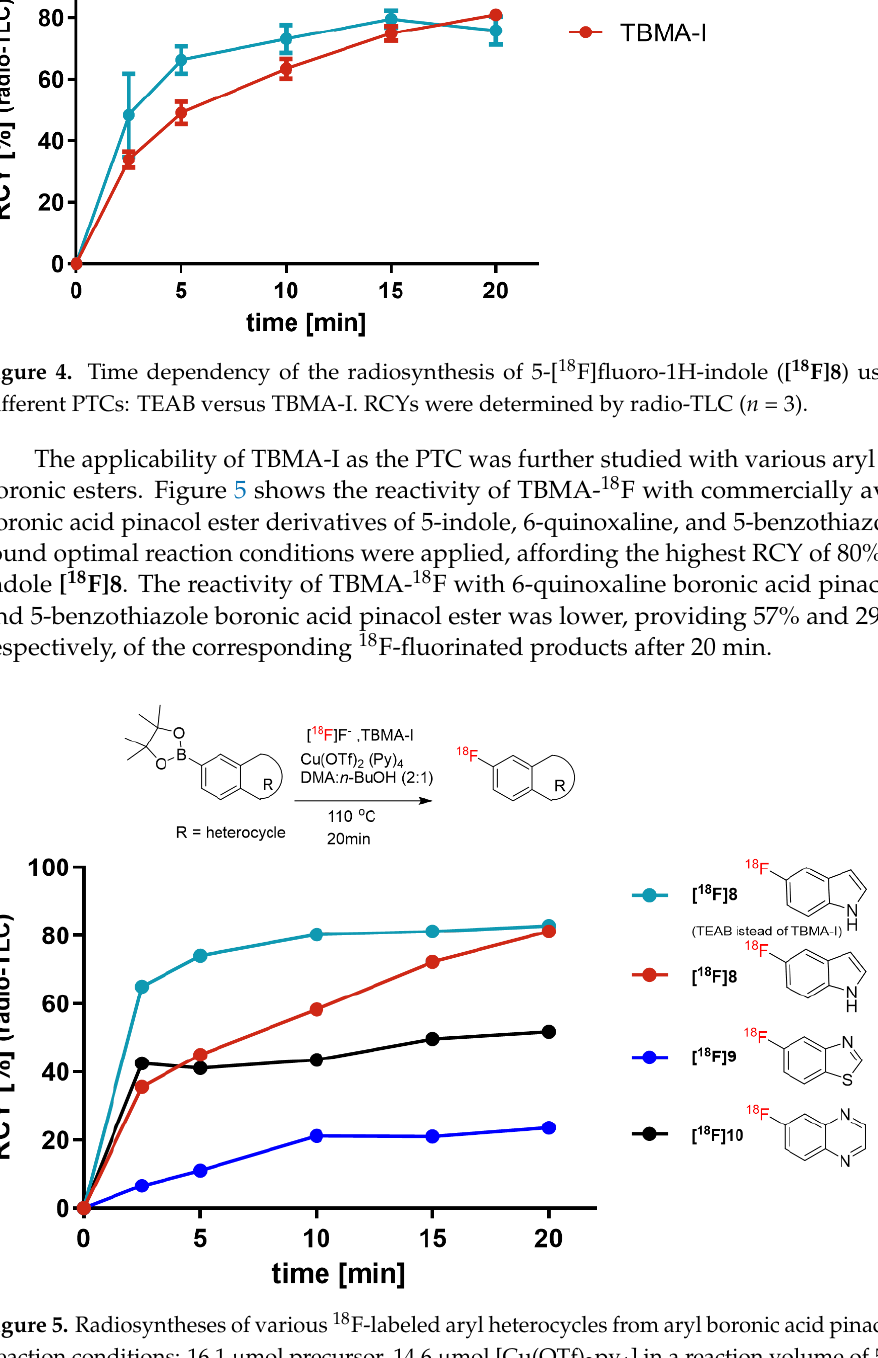
Figure 5. Radiosyntheses of various 18 F-labeled aryl heterocycles from aryl boronic acid pinacol esters (reaction conditions: 16.1 µ mol precursor, 14.6 µ mol [Cu(OTf) 2 py 4 ] in a reaction volume of 500 µ